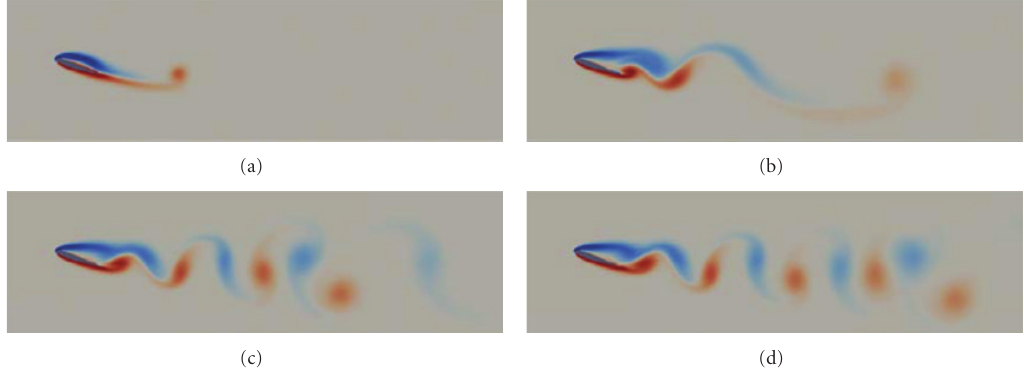
Figure 20: Vorticity plots of Re = 400 when M = 3 for t = 1 . 9 (a), 6.3 (b), 10.7 (c), and 12.9 (d).